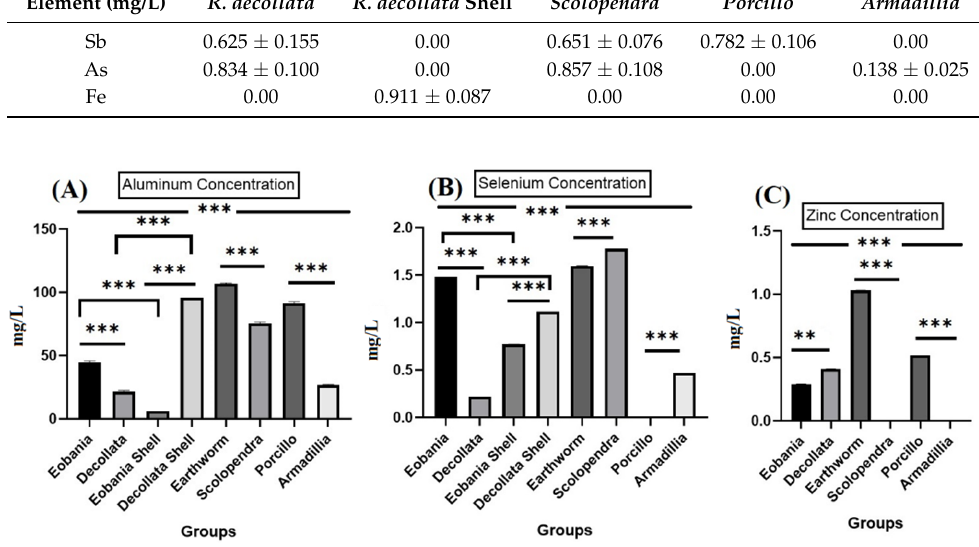
Figure 6. Assessment of aluminum ( A ), selenium ( B ), and zinc ( C ) present in the filtrate of different terrestrial biota in mg/L. *** indicates p ≤ 0.001 and ** indicates p ≤ 0.01 by comparing related samples with each other. Zinc was recorded in a few samples only, in which it was found in higher concentra- tion in R. decollata soft tissue (0.41 ± 0.06 mg/L) in comparison to E. (0.29 ± 0.08 mg/L). Zn was found with the highest concentration in earthworm (1.03 ± 0.03 mg/L). Anti- mony was found in low concentration in R. decollata (0.624 ± 0.155 mg/L), Scolopendra (0.651 ± 0.076 mg/L), and Porcillo (0.782 ± 0.106 mg/L). Arsenic was found also in low concentration in R. decollata (0.83 ± 0.10 mg/L), Scolopendra (0.857 ± 0.108 mg/L), and Armadillia (0.138 ± 0.025 mg/L), and Fe was found only adsorbed on the shell of R. decollata with concentration 0.911 ± 0.087 mg/L (Table 1 and Figure